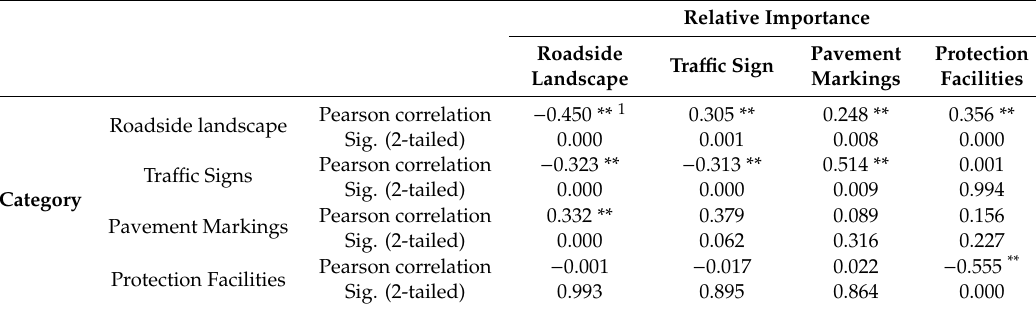
Table 7. Result of Pearson correlation